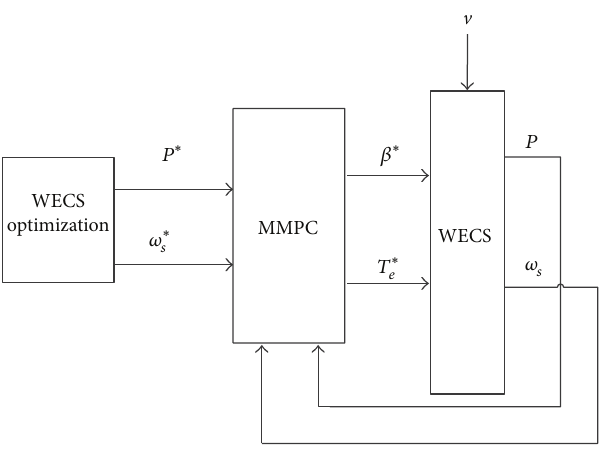
Figure6:Proposedcontrolstrategyusingmultiplemodelpredictive